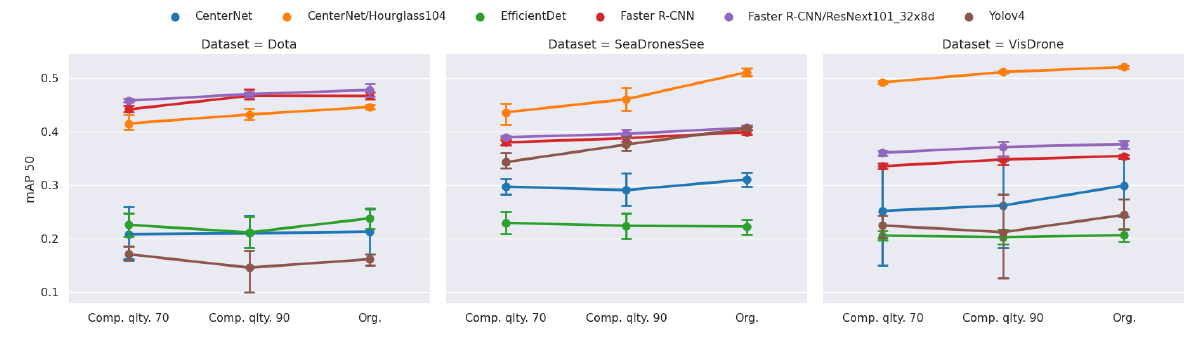
Figure 6. Compression: the impact of the JPEG compression on the performance of the object detectors for all data sets. The y-axis shows the mean Average Precision (mAP). A higher compression quality means less